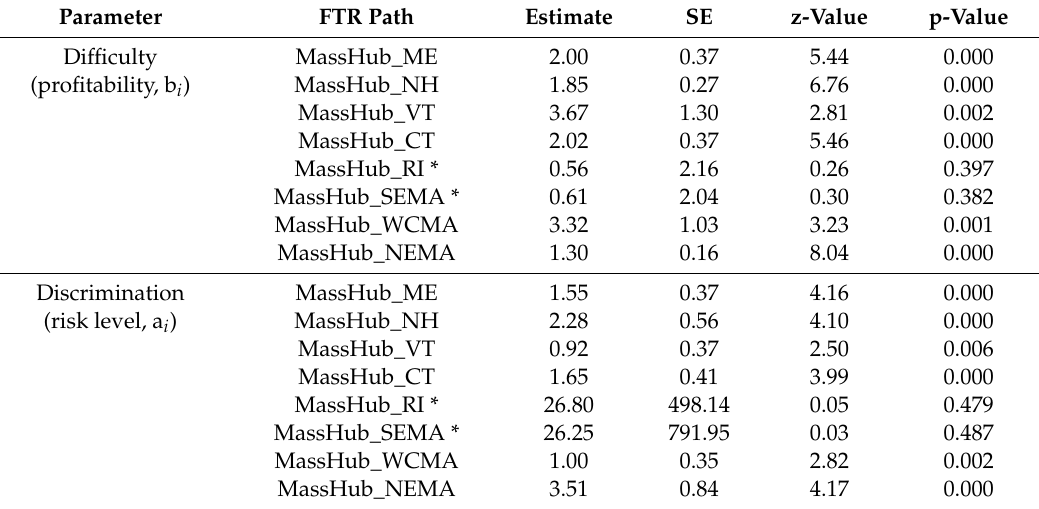
Table 2. 2PL model—path di ffi culty (profitability) and discrimination (risk) coe ffi